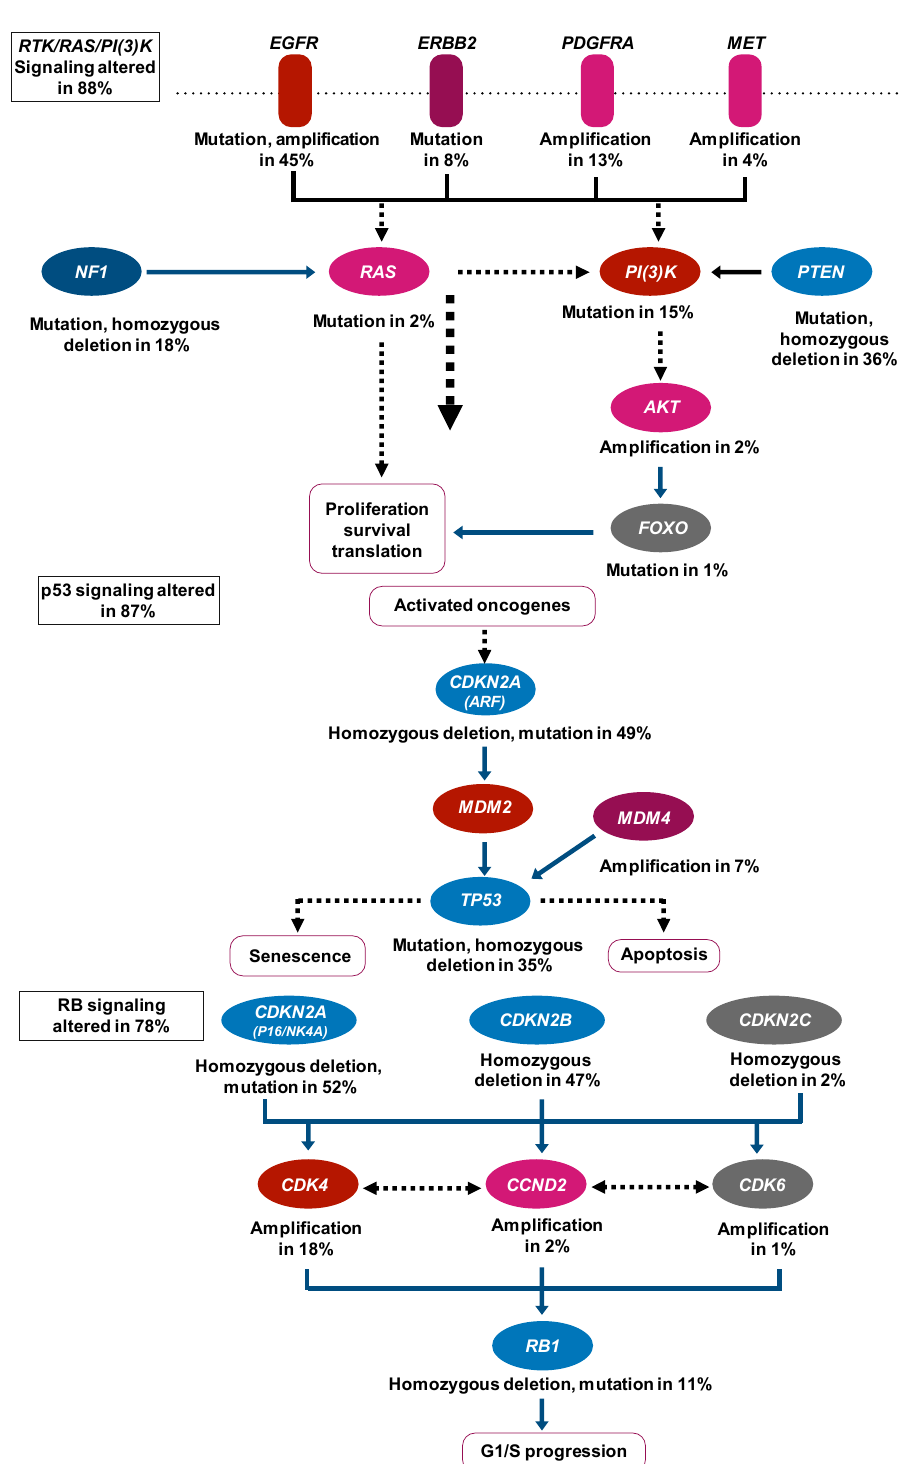
Figure 2. Expected signaling pathway changes in neuro-oncology. This result is achieved by mapping the unequivocal genetic alternations onto major pathways that are already known to be implicated in glioblastoma. Abbreviations: EGFR, Epidermal Growth Factor Receptor; ERBB2, Erb-B2 Receptor Tyrosine Kinase 2; PDGFRA, Platelet-Derived Growth Factor Receptor Alpha; MET, MET Proto-Oncogene, Receptor Tyrosine Kinase; NF1, Neurofibromin 1; PI(3)k, Phosphatidylinositol- 3 kinase; PTEN, Phosphatase and Tensin Homolog; AKT, AKT Serine/Threonine Kinas; FOXO, Forkhead Box O; CDKN2A, Cyclin-Dependent Kinase Inhibitor 2A; MDM2, MDM2 Proto-Oncogene; MDM4, MDM4 Regulator of P53; TP53, Tumor Protein P53; CDKN2B, Cyclin-Dependent Kinase Inhibitor 2B; CDKN2C, Cyclin-Dependent Kinase Inhibitor 2C; CDK4, Cyclin-Dependent Kinase 4; CCND2, Cyclin D2; CDK6, Cyclin-Dependent Kinase 6; RB1, RB Transcriptional Corepressor